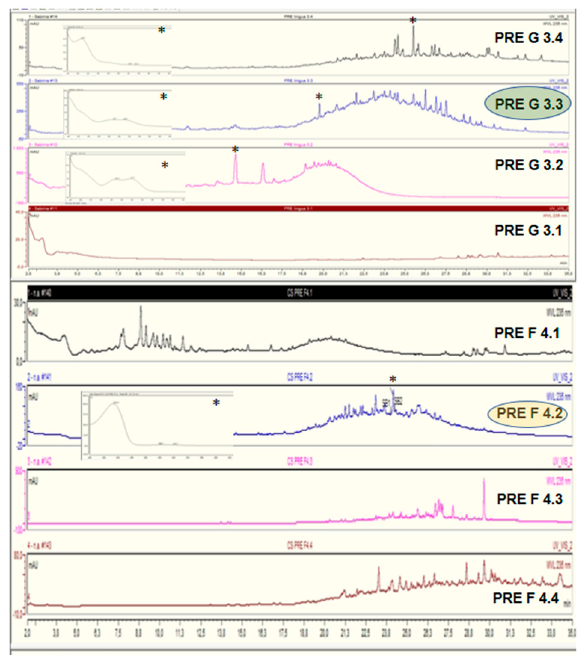
Figure A1. Chemical profile of the SPE-C18 fractions obtained from C. sylvestris . The chromatographic profiles of the SPE-C18 fractions indicate that they are rich in clerodane diterpenes and possibly tannins. Asterisks (*) indicate which chromatographic band corresponds to the UV spectrum.